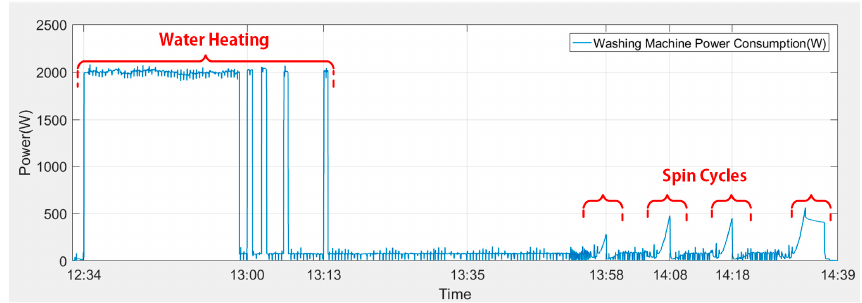
Figure 6. The power consumption of the washing machine for the cotton and synthetics washing programs at 40 °C.